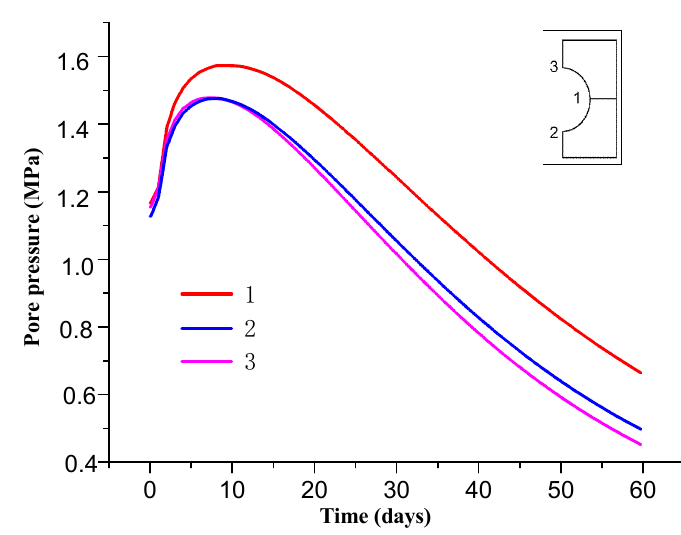
Figure 6. Variation curve of pore pressure of surrounding rock over time.